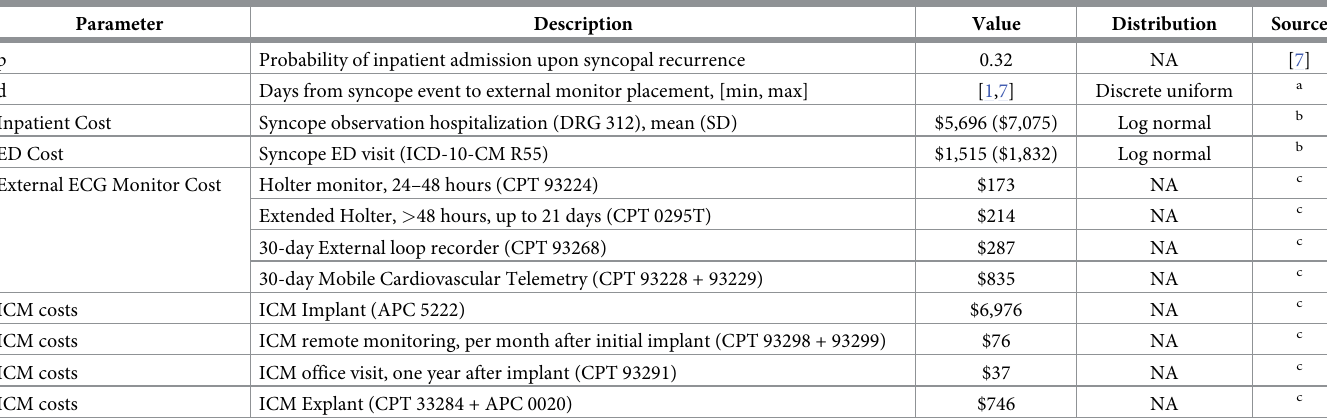
Table 1. Simulation parameters.